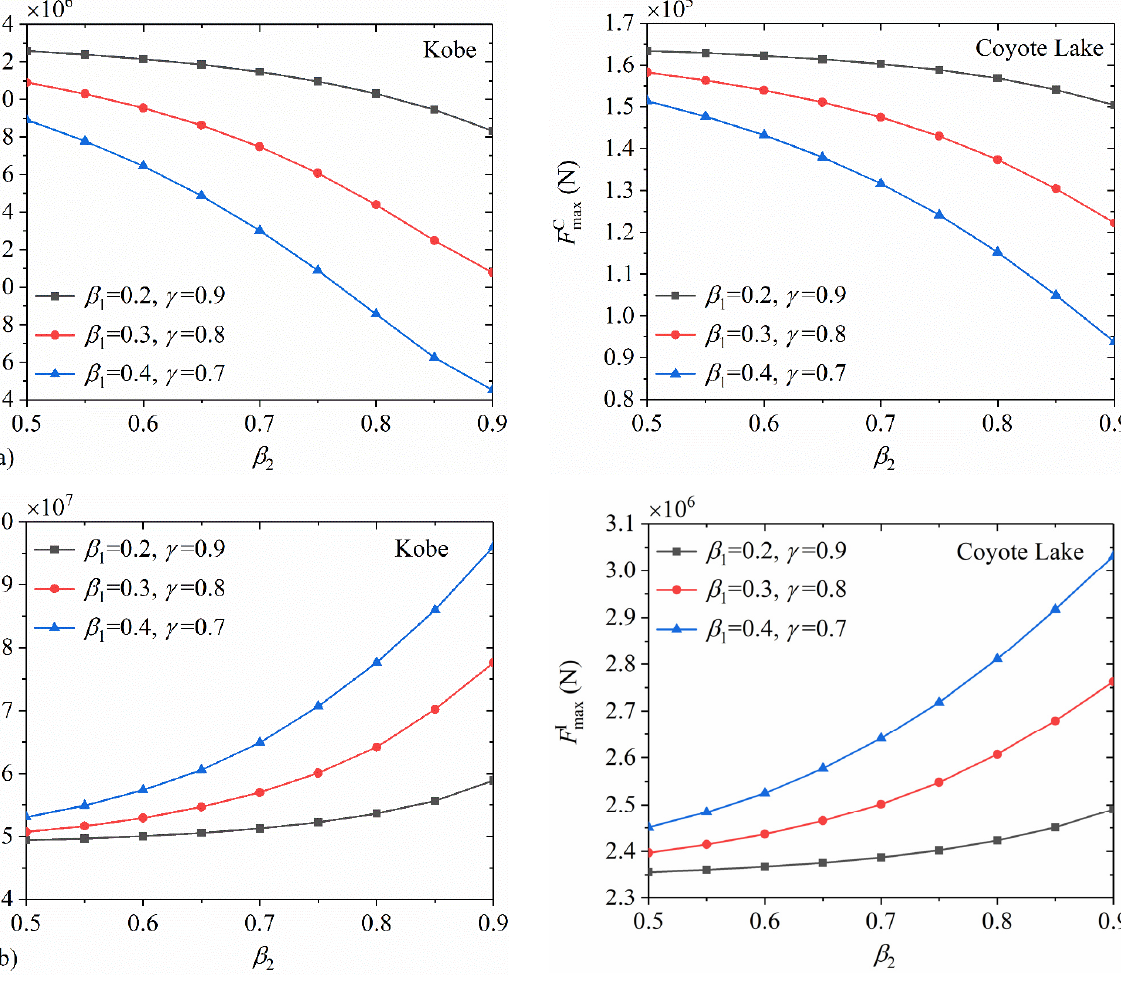
β : ( a ) the con- β : ( a ) the con- 2 2